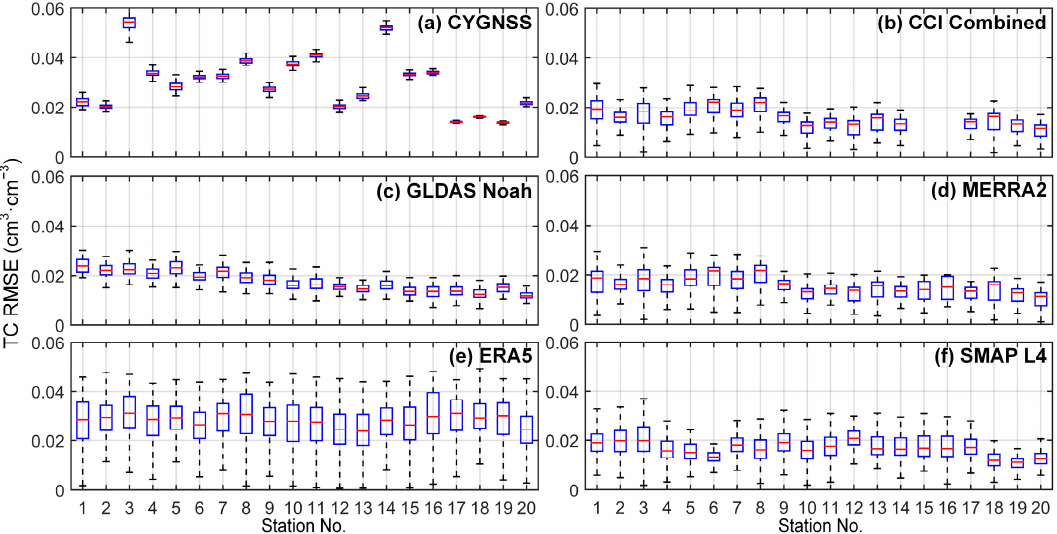
Figure 7. TC-based RMSE values of the six soil moisture products at the 20 stations. Each boxplot shows the distribution of RMSE values derived from all triplets, including ( a ) CYGNSS SM, ( b ) CCI Combined SM, ( c ) GLDAS Noah SM, ( d ) MERRA2 SM, ( e ) ERA5 SM and ( f ) SMAP L4 SM.